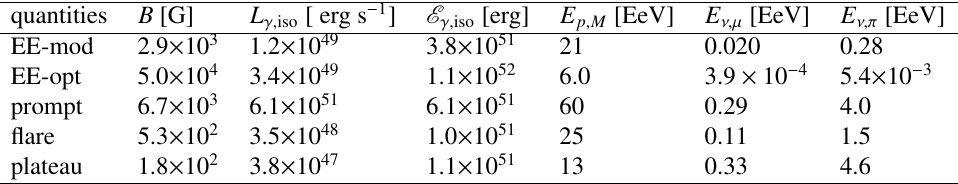
Table 2. Resulting physical quantities for each component of SGRBs. B is the magnetic field in the dissipation region, L γ, iso and E γ, iso are the total isotropic equivalent luminosity and energy fluence, E p , M is the maximum energy for protons, E ν,µ is the critical neutrino energy above which the muon cooling is e ff ective, E ν,π is the break energy of neutrino spectrum due to pion cooling. This table is adapted from [19].